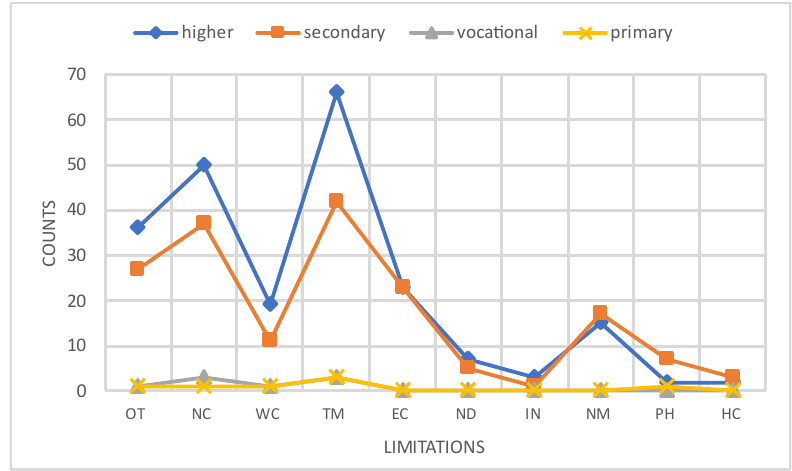
Figure 26. A graph of the interaction between the limitations to bus availability and the education level of the respondent.